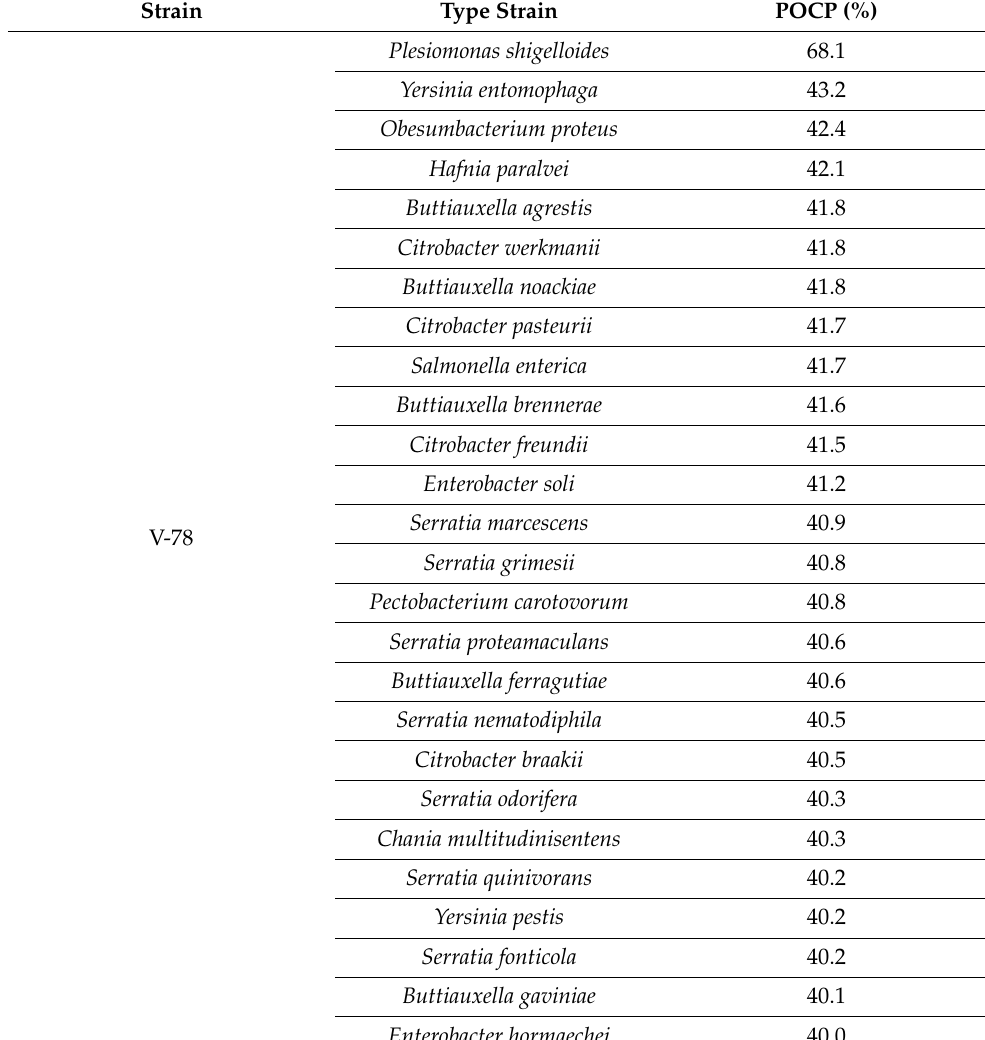
Table 2. Percentage of conserved proteins (POCP) of strain V-78 from related type strains, as calculated by the